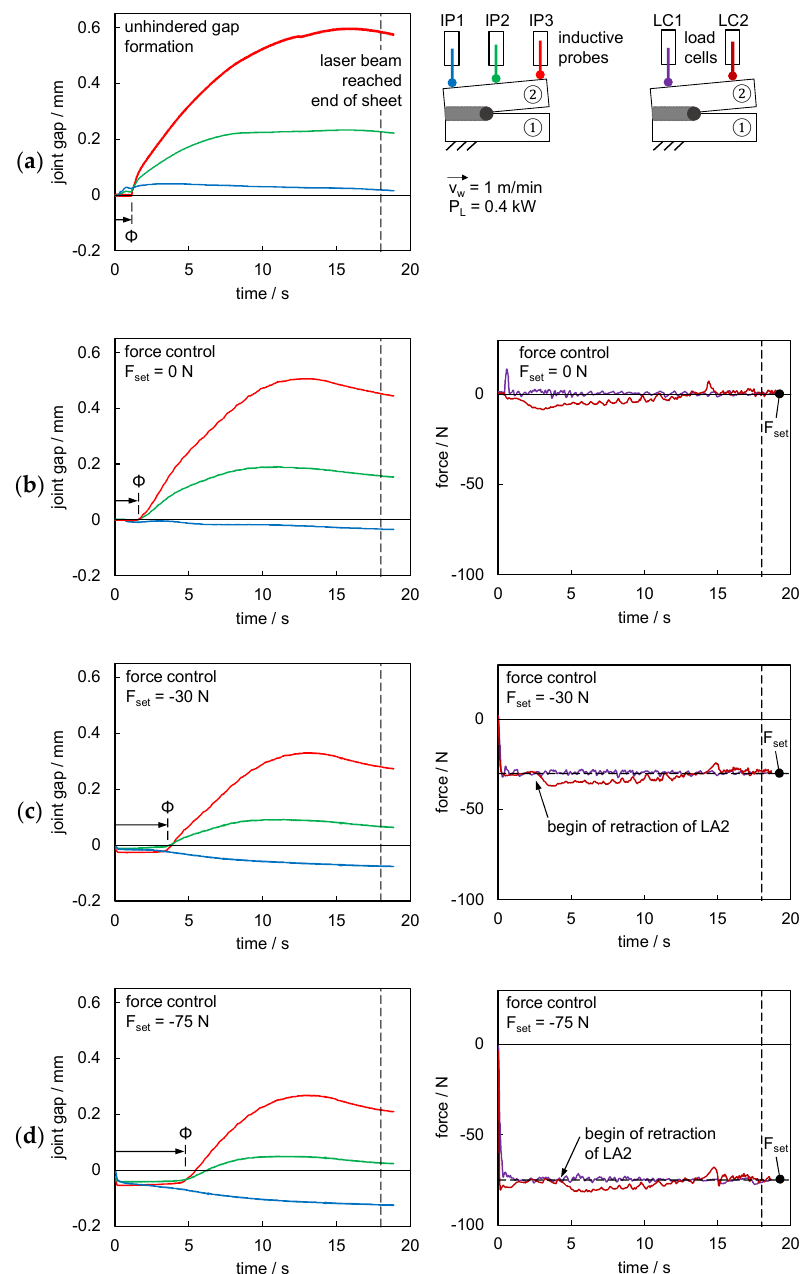
Figure 13. Closed-loop compression force control (v w = 1 m/min, P L = 0.4 kW): ( a ) unhindered gap formation; ( b ) setpoint value 0 N; ( c ) setpoint value −30 N; and ( d ) setpoint value −75 N.